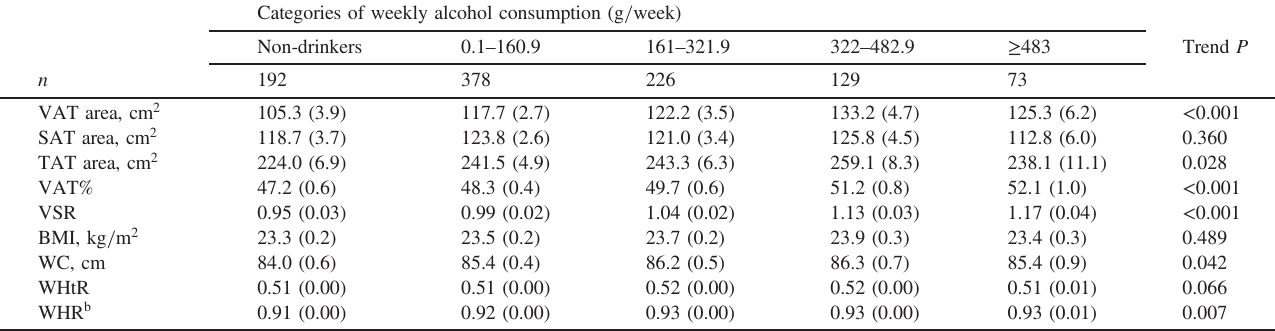
Table 2. Adjusted mean values a of obesity indices according to weekly alcohol consumption in 998 men aged 40 – 79 years (SESSA, Shiga, Japan, 2006 – 2008)